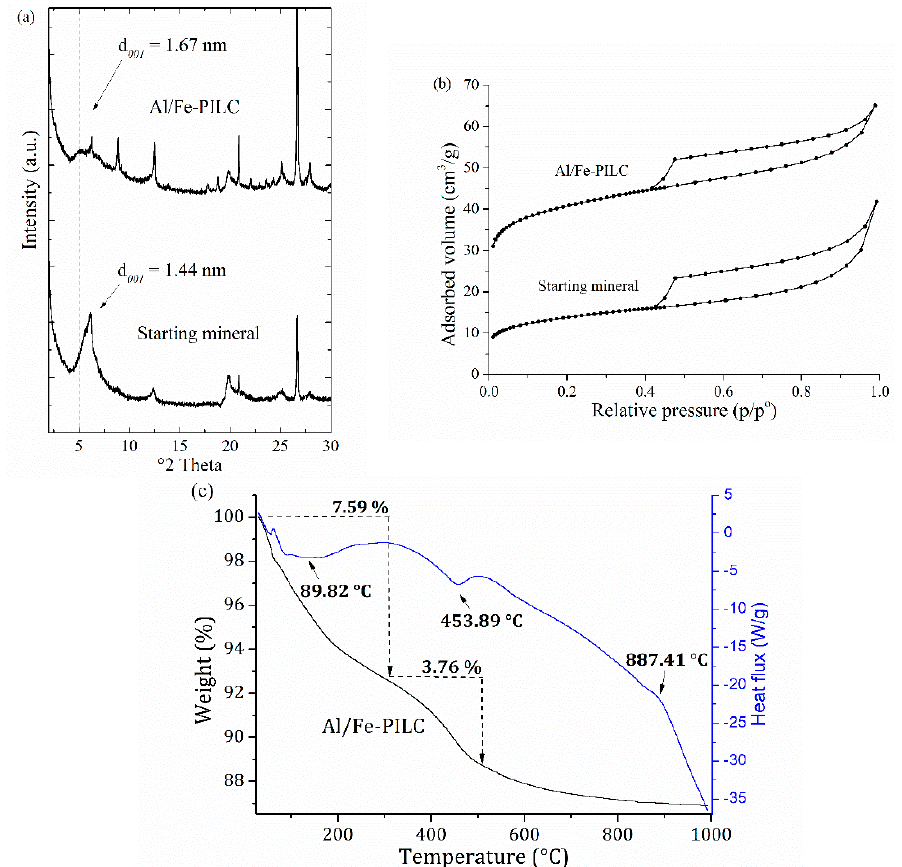
Figure 1. Physicochemical characteristics of the starting material and the Al/Fe-PILC clay catalyst: ( a ) Powder XRD patterns; ( b ) Nitrogen adsorption/desorption isotherms; ( c ) Simultaneous thermal analysis (TGA/DSC) of the Al/Fe-PILC catalyst.